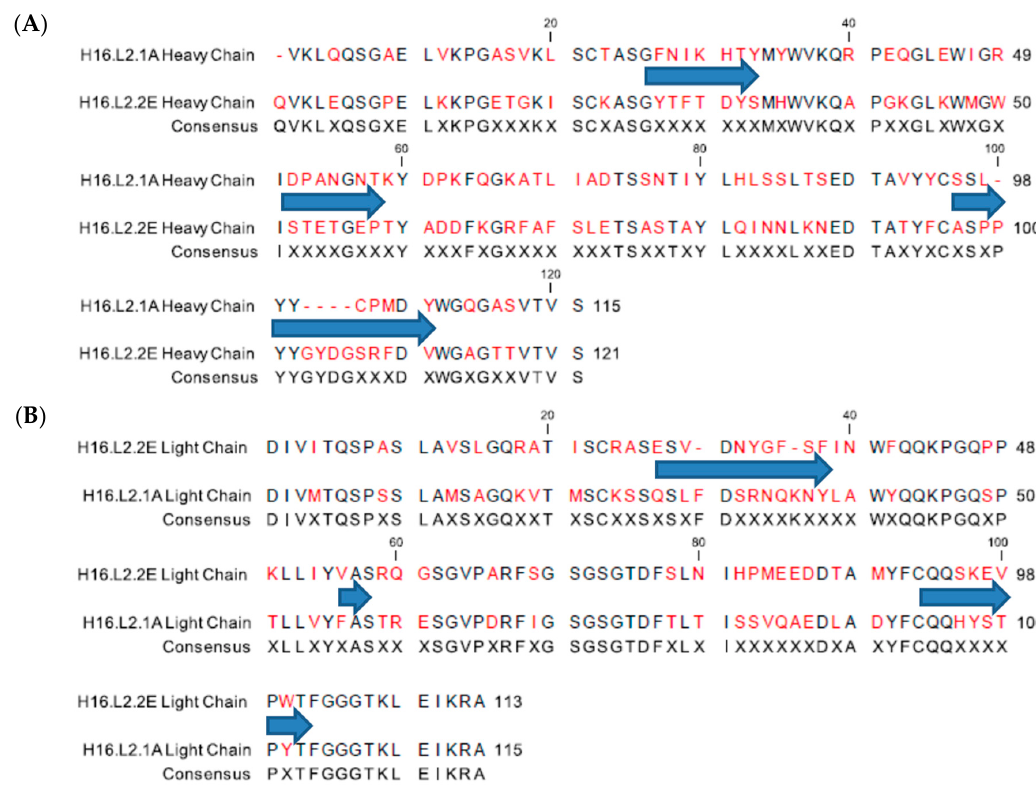
Figure 1. Sequence alignment of the H16.L2.2E and H16.L2.1A ( A ) heavy chain and ( B ) light chain variable regions. Sequences were aligned using CLC Main Workbench (QIAGEN, Redwood City, CA, USA) and complementarity determining regions (CDRs) were determined using IMGT/V-QUEST). The complementarity determining regions are demarcated by blue arrows. A consensus sequence is displayed below the alignment and residues highlighted in red indicate amino acid differences between the two sequences.